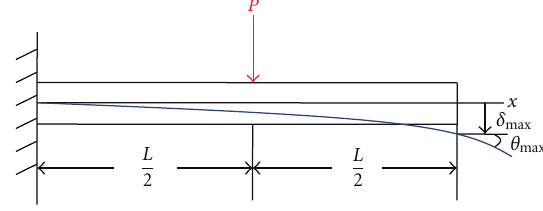
Figure 14: The lifting arm considered as a cantilever